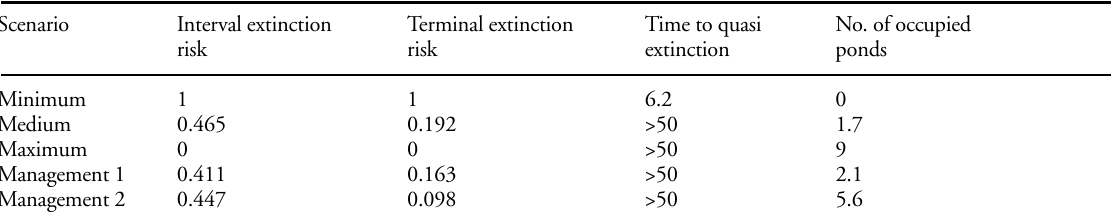
Table 2. Extinction risks for the great crested newt in the study area under different scenarios: minimum estimates of uncertain parameters; medium estimates; maximum estimates; medium estimates with restoration of three ponds (Management 1); medium estimates with restoration of three ponds and increased pond density (Management 2). Extinction risk is expressed as the probability of a quasi-extinction in the study area (the population size in each of the populations in the study area falling below 10 females [adults + juveniles]) at least once during 50 years (interval extinction risk); the probability that the great crested newt in the study area will end up quasi-extinct after 50 years (terminal extinction risk); the median time to quasi-extinction in the study area in years (time to quasi- extinction); the average number of occupied ponds in the study area after 50 years (no. of occupied ponds). Scenario Interval extinction Terminal extinction Time to quasi No. of occupied risk risk extinction